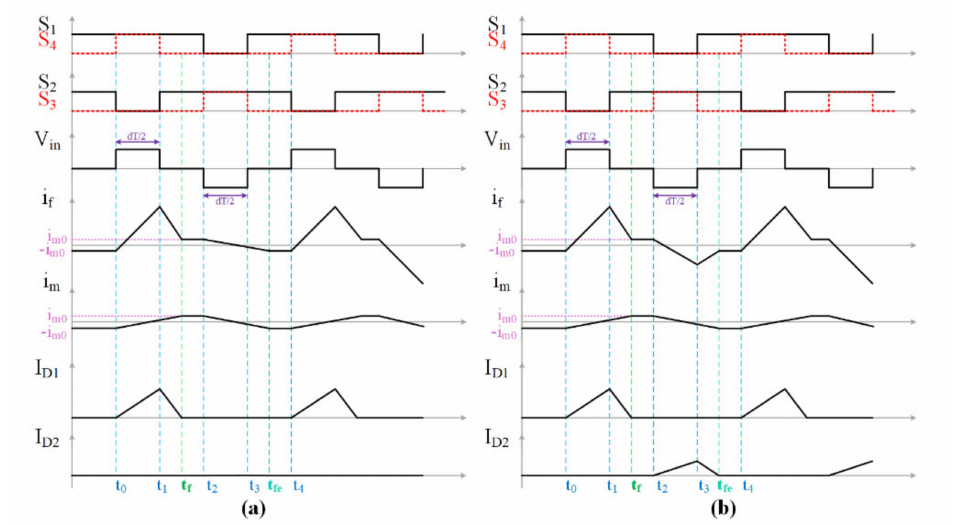
Figure 4. Theoretical waveforms in the steady-state of the proposed equalizer whereas: ( a ) V c1 is the lowest voltage between all capacitors; ( b ) V c1 \ V c2 is the lowest voltage between the odd \ even numbered